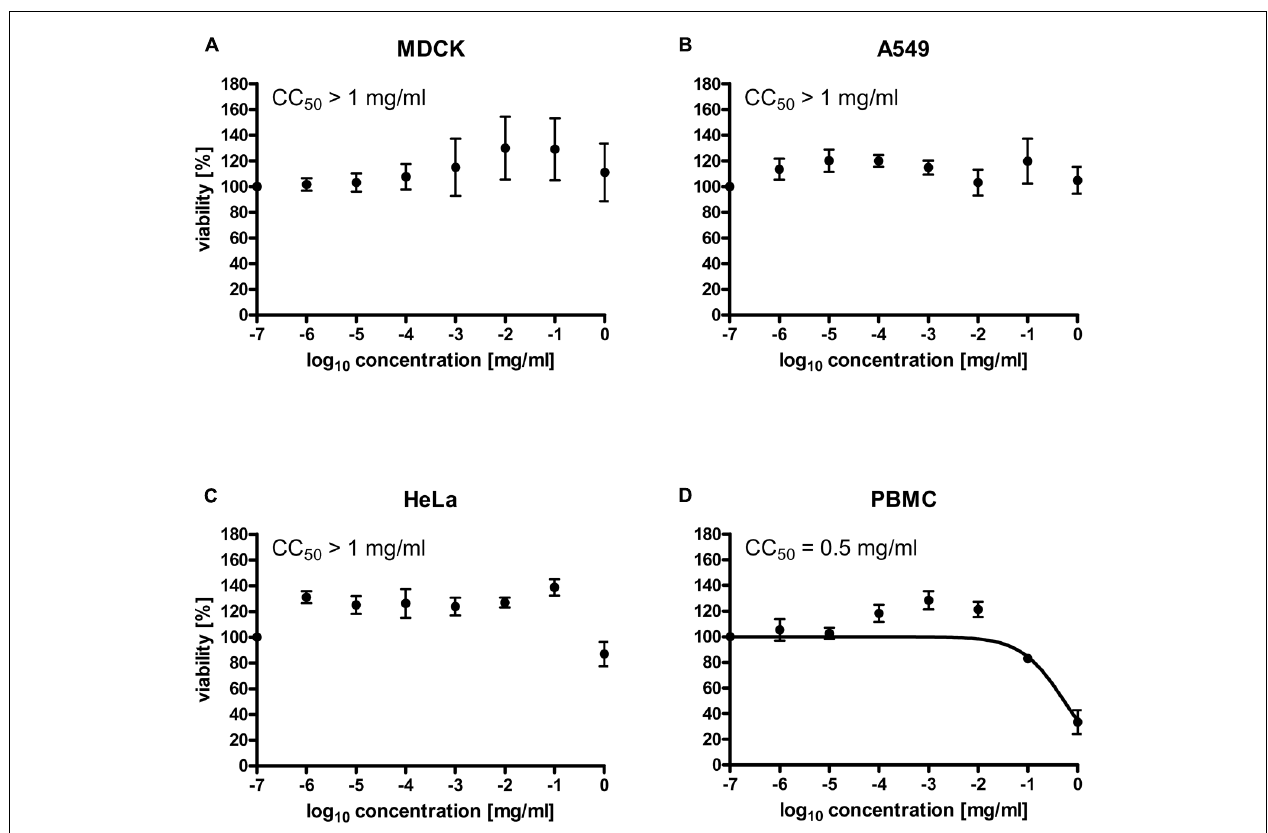
FIGURE 1 | Ladania067 treatment shows no cytotoxic effects in vitro . The cytotoxic concentration 50% (CC 50 ) of Ladania067 was determined in MDCK (A) , A549 (B) , HeLa (C) , and PBMCs (D) . Cells were